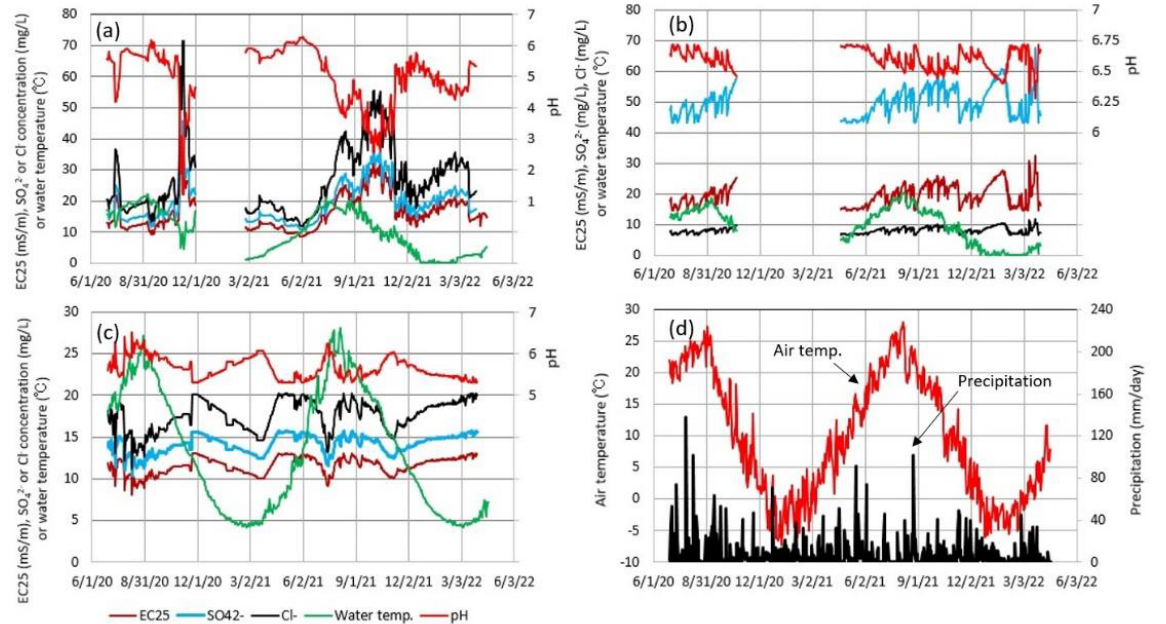
Figure 10. Temporal variations of daily mean EC25, Cl − concentration, SO 42 − concentration, water temperature and pH in ( a ) Tama River, ( b ) Sendachi River and ( c ) Lake Tazawa (0.2 m depth), and ( d ) daily precipitation and daily mean air temperature for 29 June 2020 – 31 March 2022.